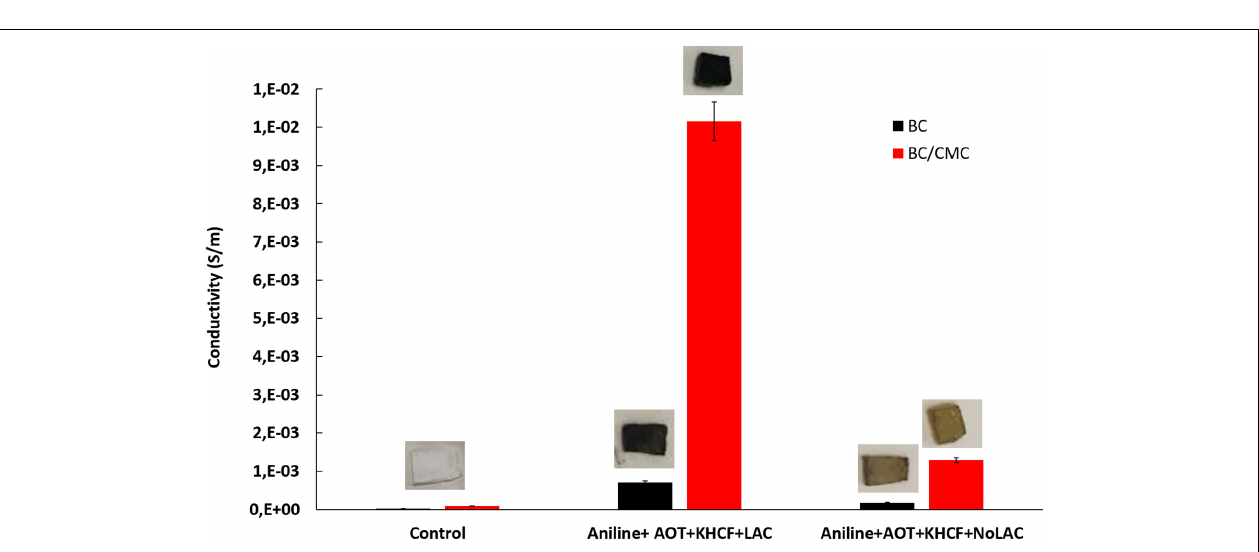
FIGURE 7 | Conductivity of BC and BC/CMC functionalized with polyaniline oxidized by laccase in the presence of additives, AOT and KHCF; images of the samples are presented in the upper part of each graph bar.